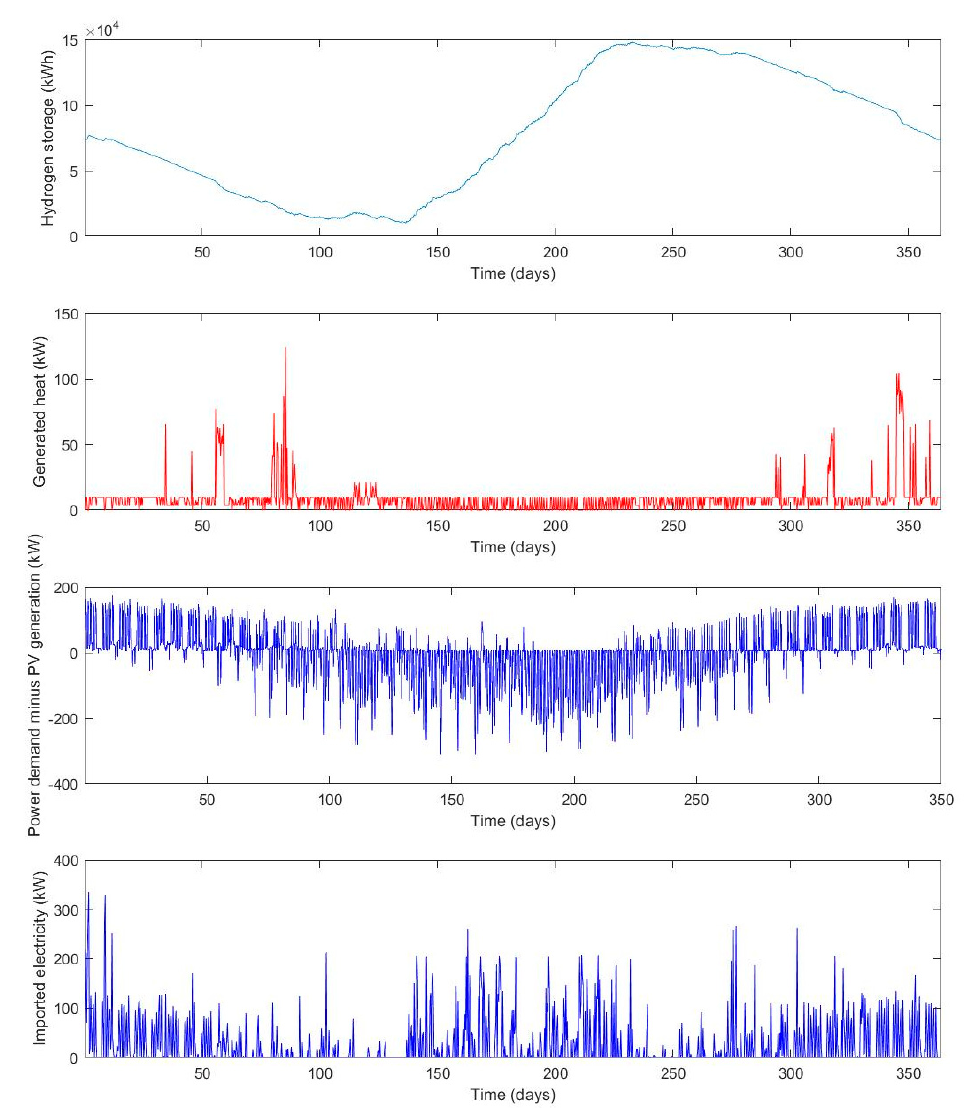
Figure A6. Optimal operation of a 50 / 200 kW RSOC system with 3000 m 2 solar PV panel.